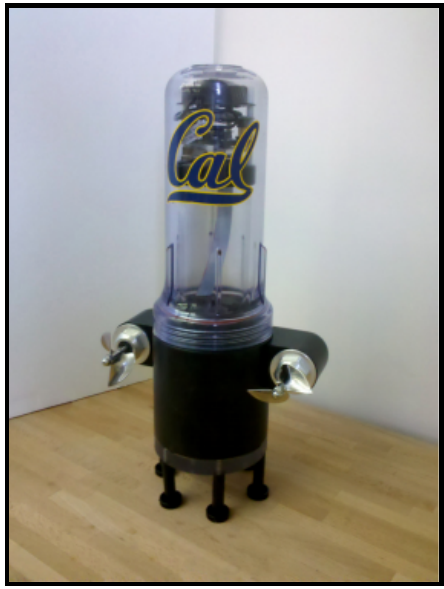
Figure 6. Generation 3 drifter floating sensor [18].